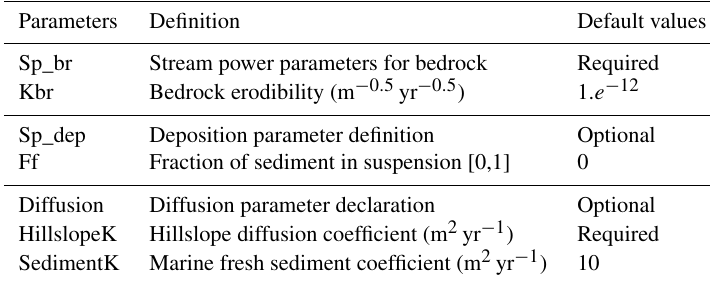
Table 3. Input parameters relative to physical